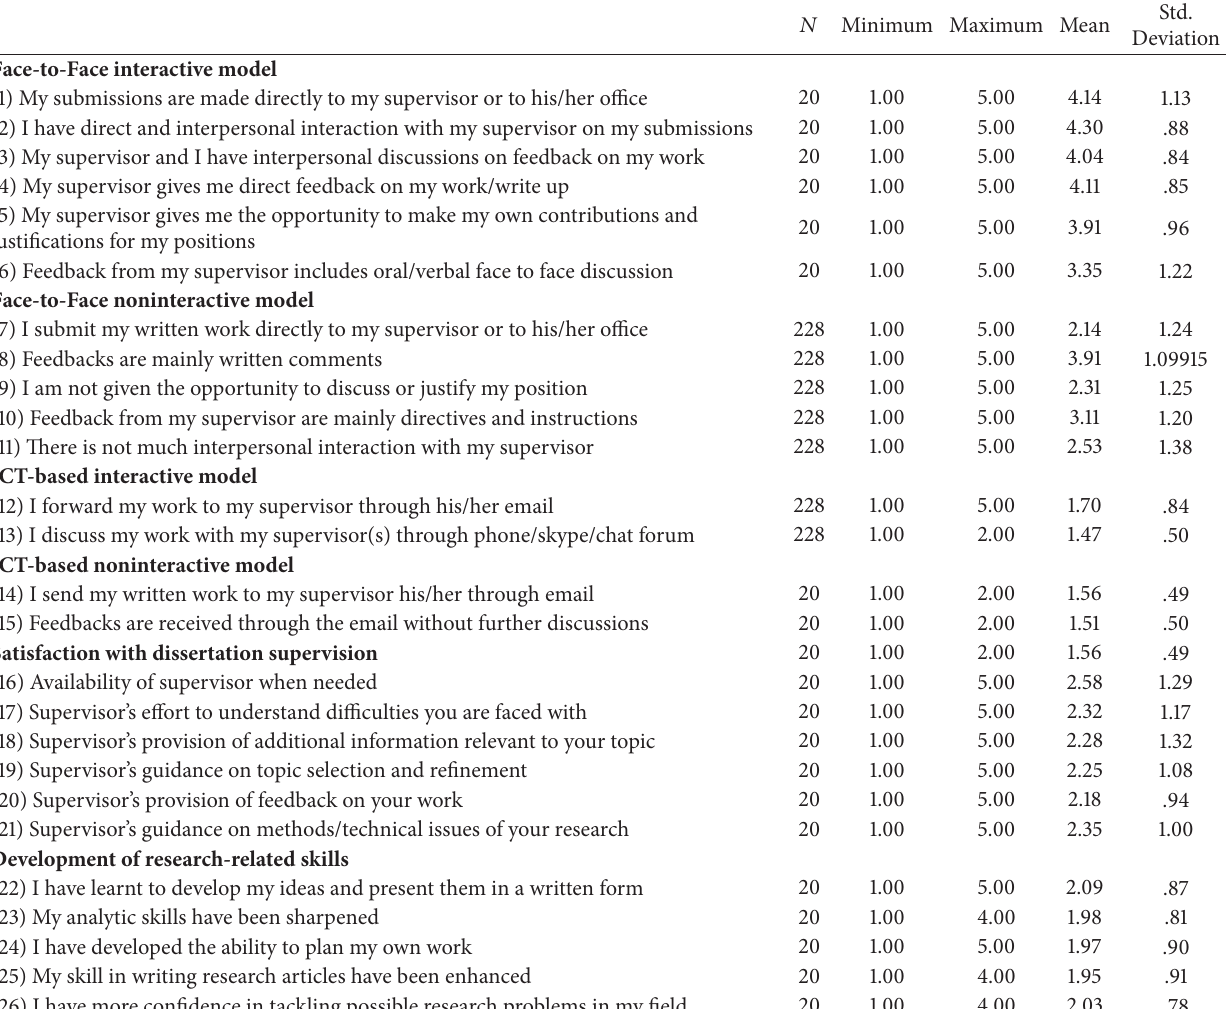
Table 1: Questionnaire items’ mean and standard deviation